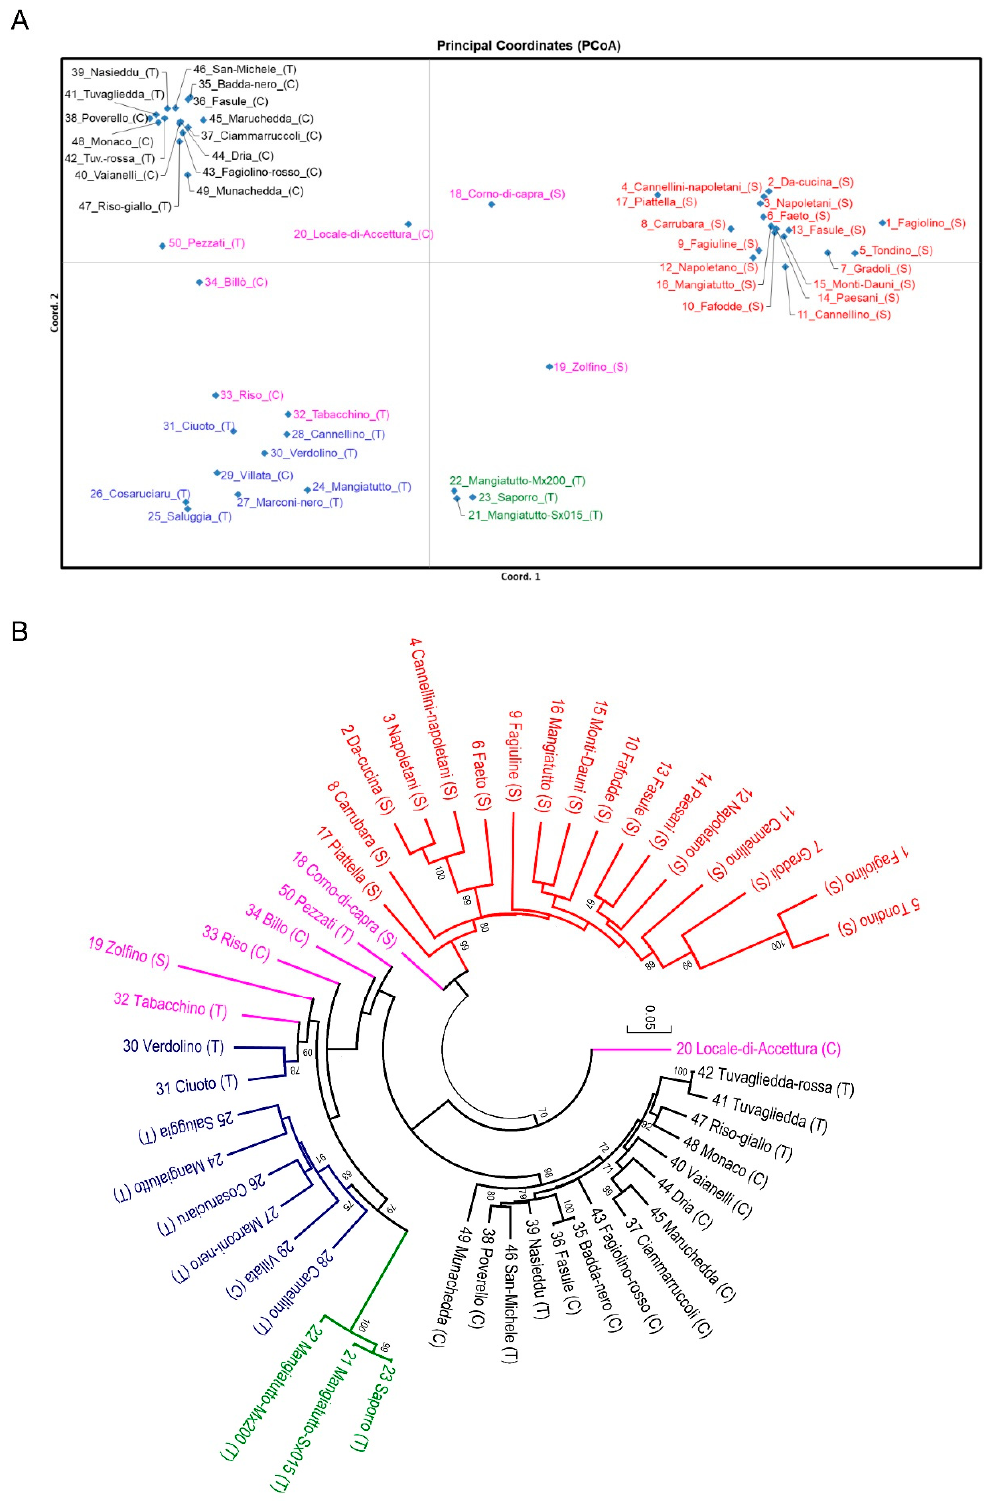
Figure 2. ( A ) Graph of the first two axes from a principal coordinate analysis (PCoA) of common bean genotypes used in this study. Colors refer to groups in K = 4 of Figure 1, except for the yellow group, which is black, and the admixed samples, which are fuchsia colored. ( B ) Neighbor joining tree based on Tamura–Nei genetic distance derived from single nucleotide polymorphism (SNP) analysis. Bootstrap values ≥ 60 are shown. Common bean accessions are indicated with a progressive number, common name, and phaseolin pattern (in brackets).